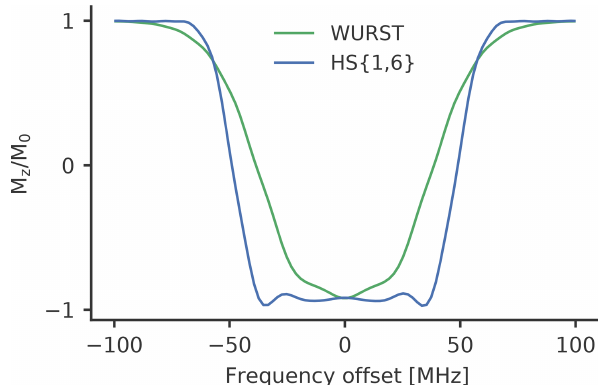
Figure 4. Calculated inversion profiles of a WURST ( n = 12, green) and a HS { 1 , 6 } (truncation parameter of 6 /t p , blue) pulse with a pulse length of 100ns and a sweep width of 100MHz nor- malised to ν 1 = 30MHz, which corresponds to the maximum of the measured resonator